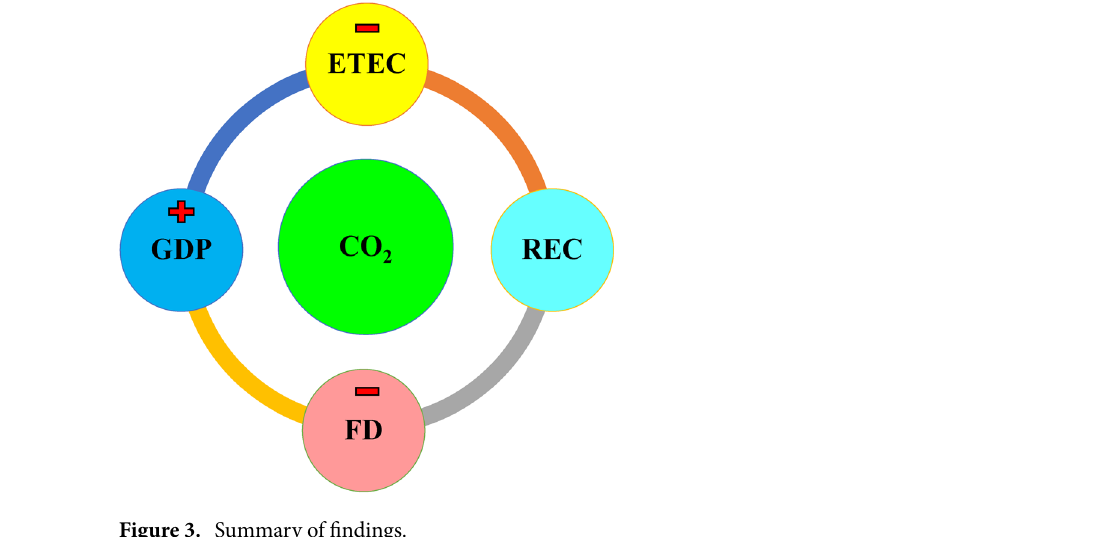
Figure 3. Summary of findings.